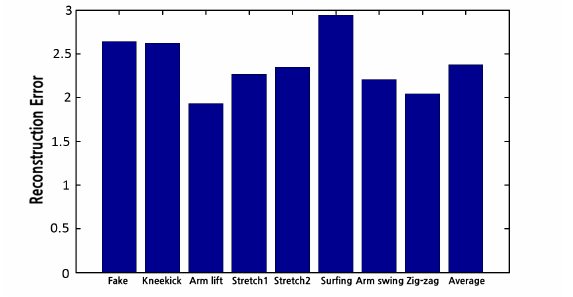
Figure 14. Reconstruction errors of eight actions using the Samba motion capture system. The average reconstruction error is 2.37 cm.